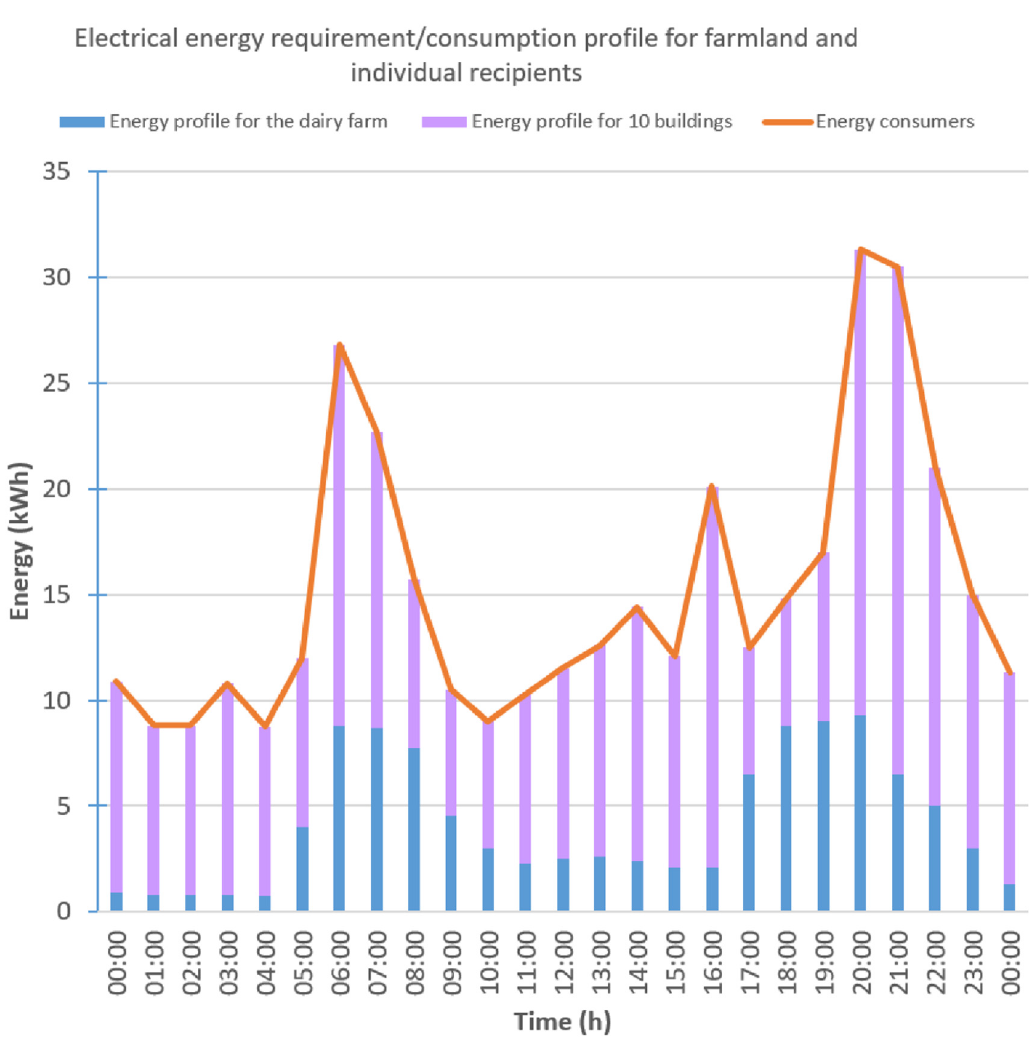
Figure 10. Electrical energy requirement/consumption profile for farmland and individual recipients and a summary of the energy usage for the analysed energy flow circuit. Own study based on source [55].